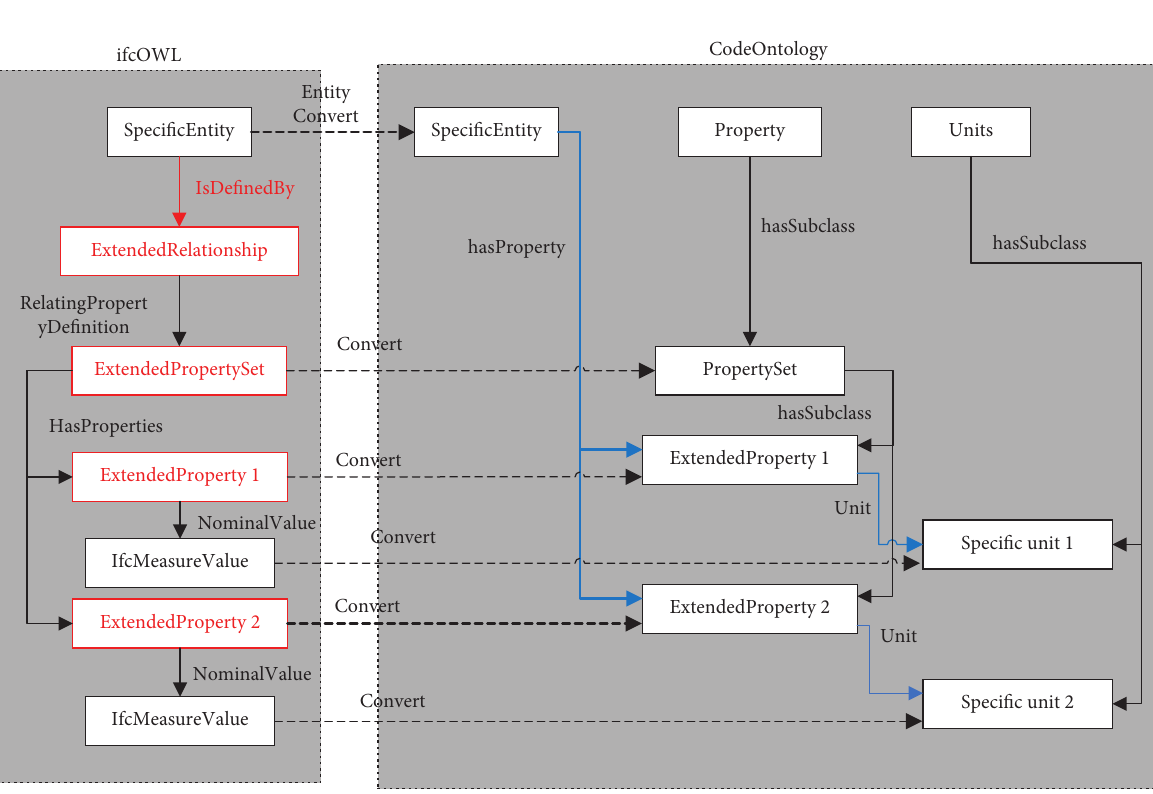
Figure 8: The property conversion method.